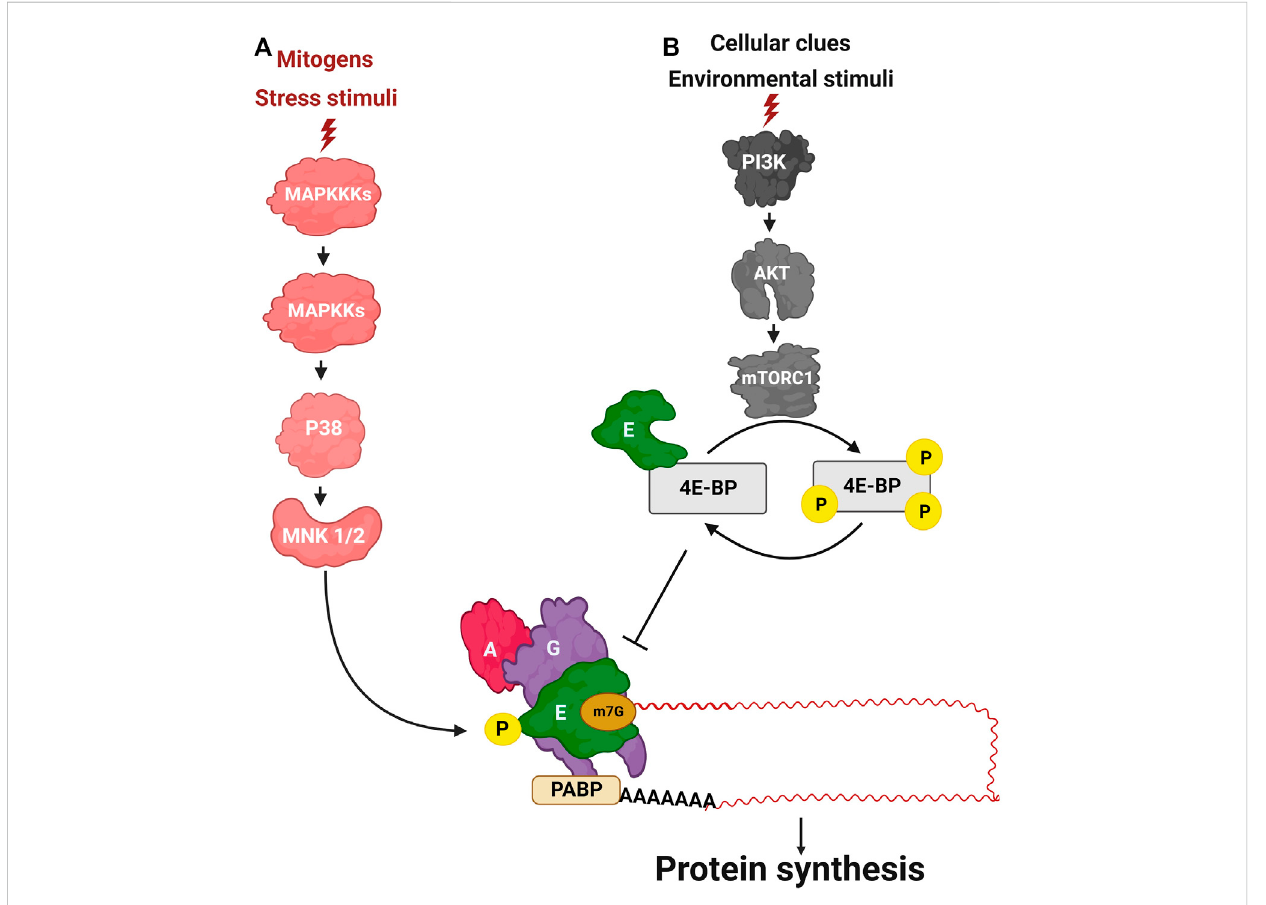
FIGURE 2 The transduction cascades signaling to translation initiation. (A) The MAPK pathway. (B) The PI3K/AKT/mTOR